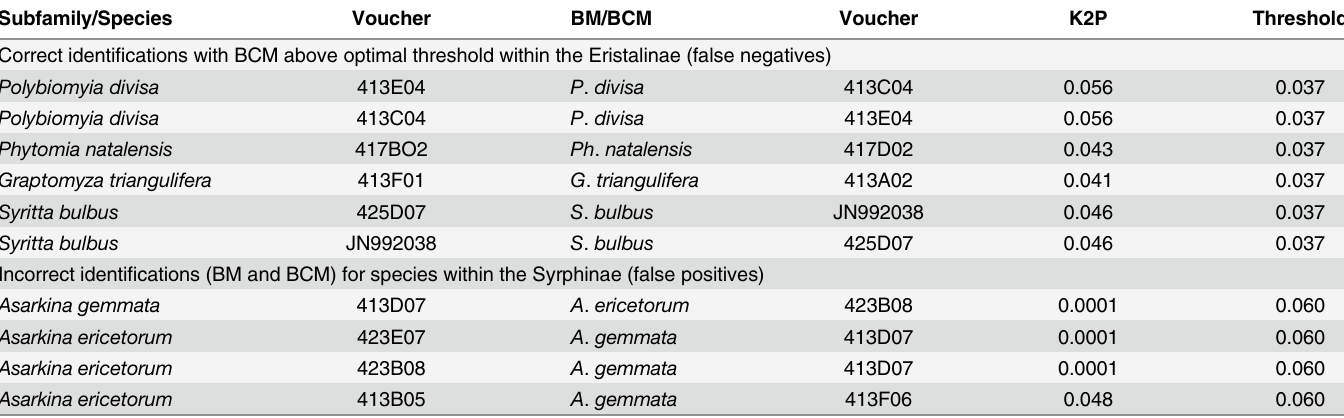
Table 3. Specific results for the Best Match (BM) and Best Close Match (BCM) identification methods (see also Table 2). The last column gives the optimal threshold used for the BCM method (see text and [35]). Subfamily/Species Voucher BM/BCM Voucher K2P